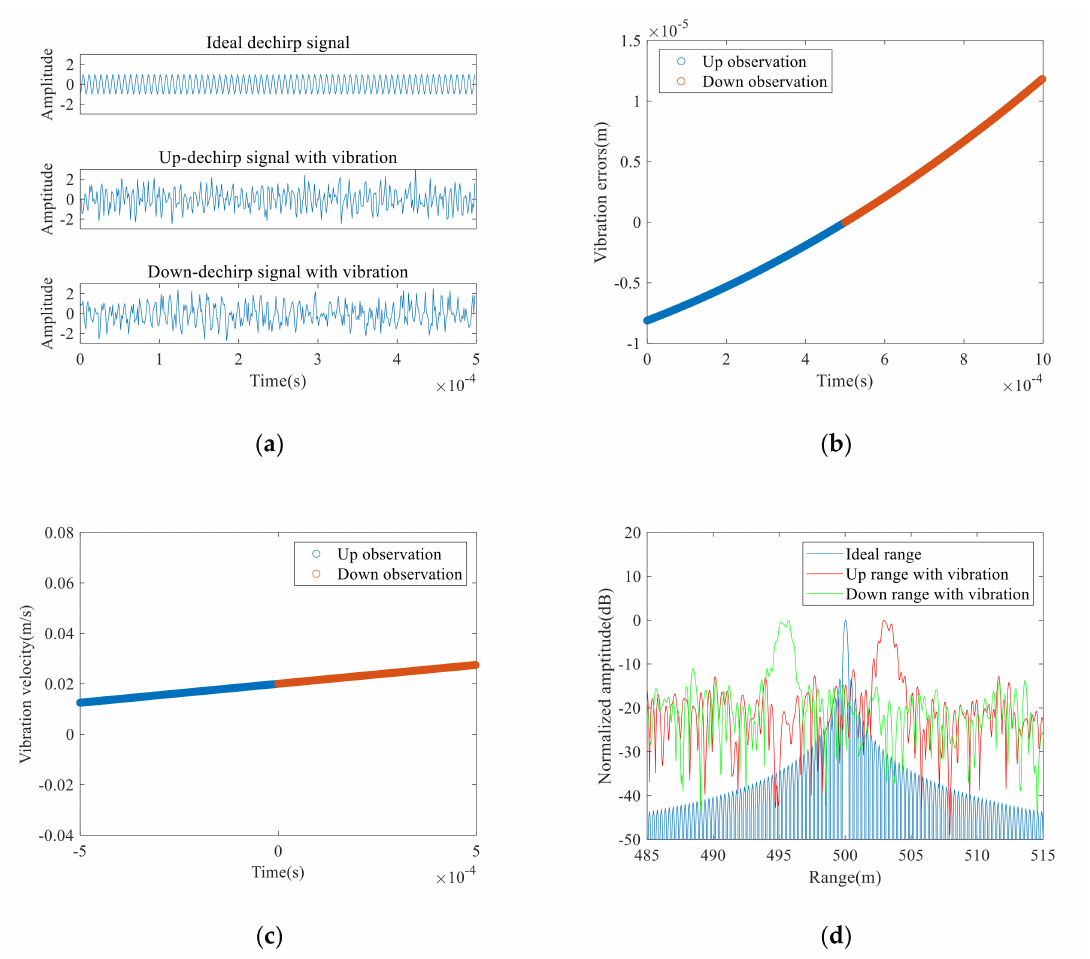
Figure 5. ( a ) Dechirp signals, ( b ) Vibration errors of up and down observations, ( c ) Vibration velocities of up and down observations and ( d ) One-dimensional range distributions under the environment of time-varying vibrations and